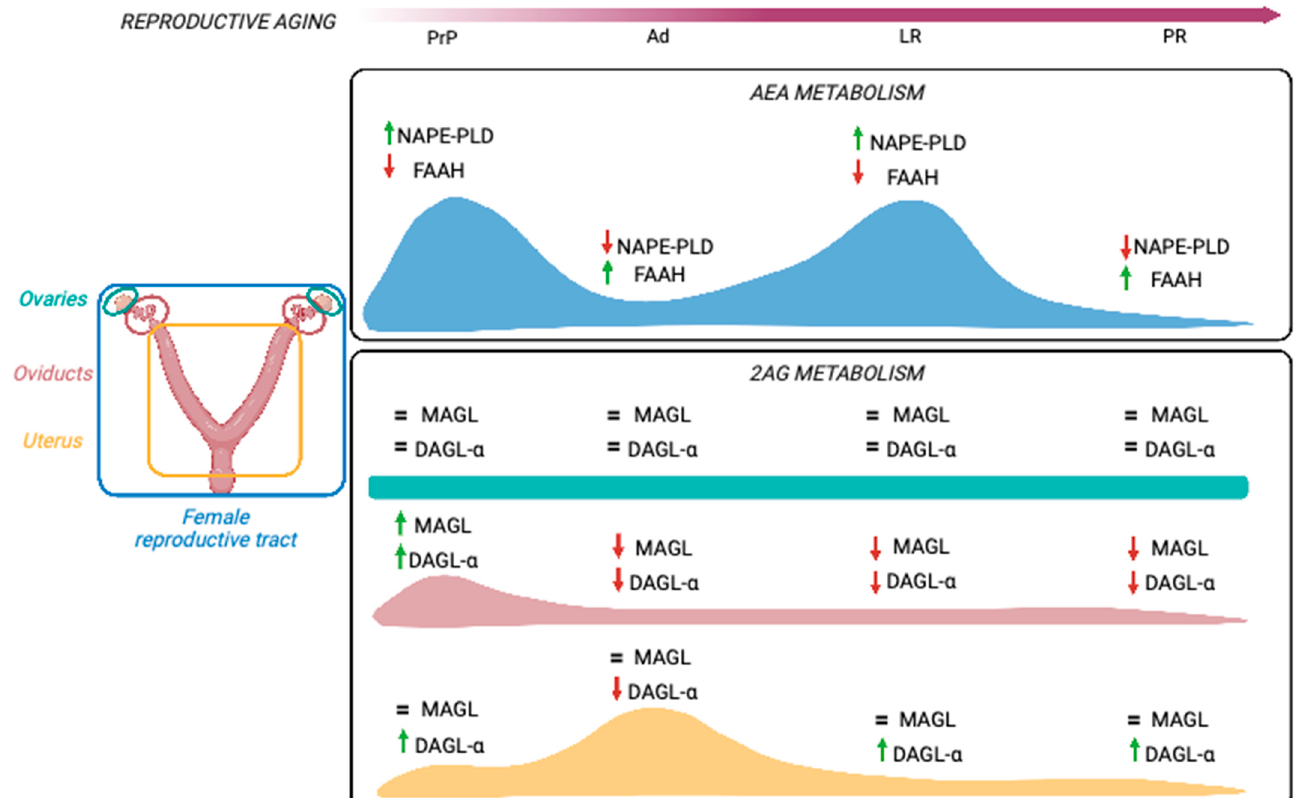
Figure 5. Schematic representation of age-related modulation of ECS in the female reproductive tract. A similar regulation of AEA metabolic enzymes is apparent in all organs (blue curve), whereas 2-AG metabolism seems to be di ff erentially a ff ected in an organ-speci fi c manner (green: ovary, pink: oviduct, yellow: uterus). Abbreviations and annotation: Ad: adult; DAGL- α : diacylglycerol lipase α ; FAAH: fa tt y acid amide hydrolase; LR: late reproductive; MAGL: monoacylglycerol lipase; NAPE-PLD: N -acylphosphatidylethanolamine-speci fi c phospholipase D; PR: post-reproductive; PrP: prepubertal; pink arrow: reproductive aging timeline; green arrow: upregulation; red arrow: downregulation; =: unchanged.